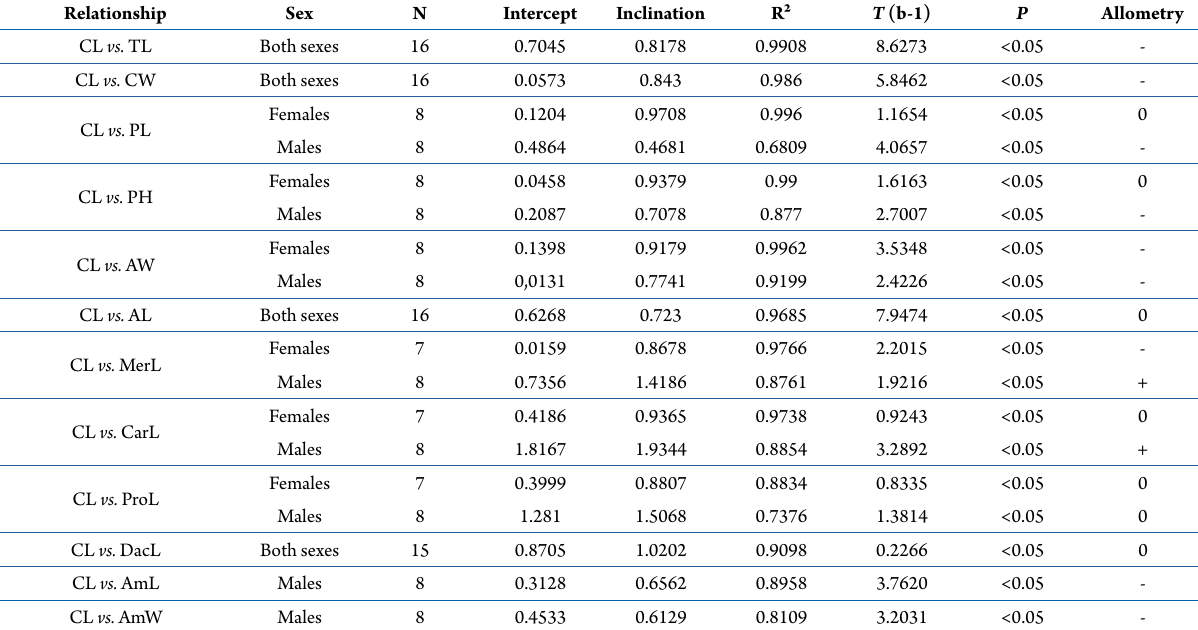
Table 4. Regression analyses of morphometric data of Atya scabra (Leach, 1816) in the Fluvial Island Domain in the Paraíba do Sul River basin. Carapace length (CL) is the independent variable. (PL) length of second abdominal pleuron; (PH) height of second abdominal pleuron; (CW) carapace width; (TL) total length; (AW) abdomen width; (AL) abdomen length; (MerL) merus length; (CarL) carpus length; (ProL) propodus length; (DacL) dactylus length; (AmL) length of male appendix interna; (AmW) width of male appendix